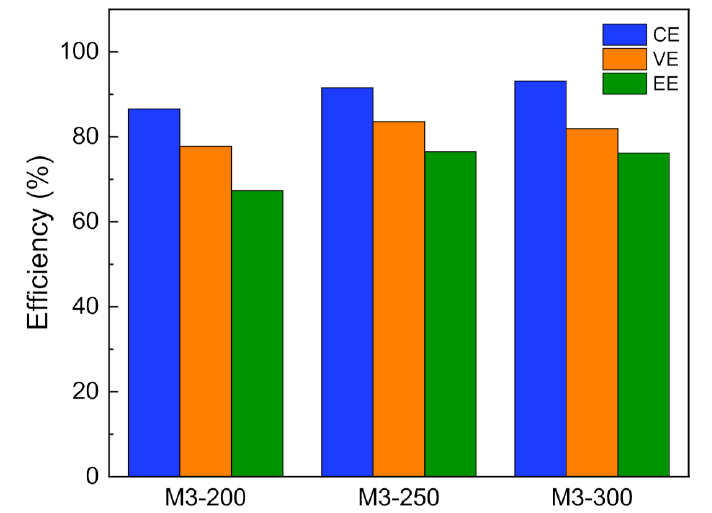
Figure 6. The performance of VFBs with M3-D at the current density of 80 mA cm − 2 . The long-term stability of M3-300 membrane was evaluated on-site by the charge- discharge cycling test of VFBs with M3-300 membrane. As shown in Figure 7, the battery using M3-300 membrane could run stably for over 50 cycles and the CE, VE, and EE of VFBs had little decay with the cycle numbers at a current density of 80 mA cm − 2 , exhibiting good stability. These results indicate that the pore structure of the PAN porous membrane after the solvent post-processing is stable during the running process in VFB.